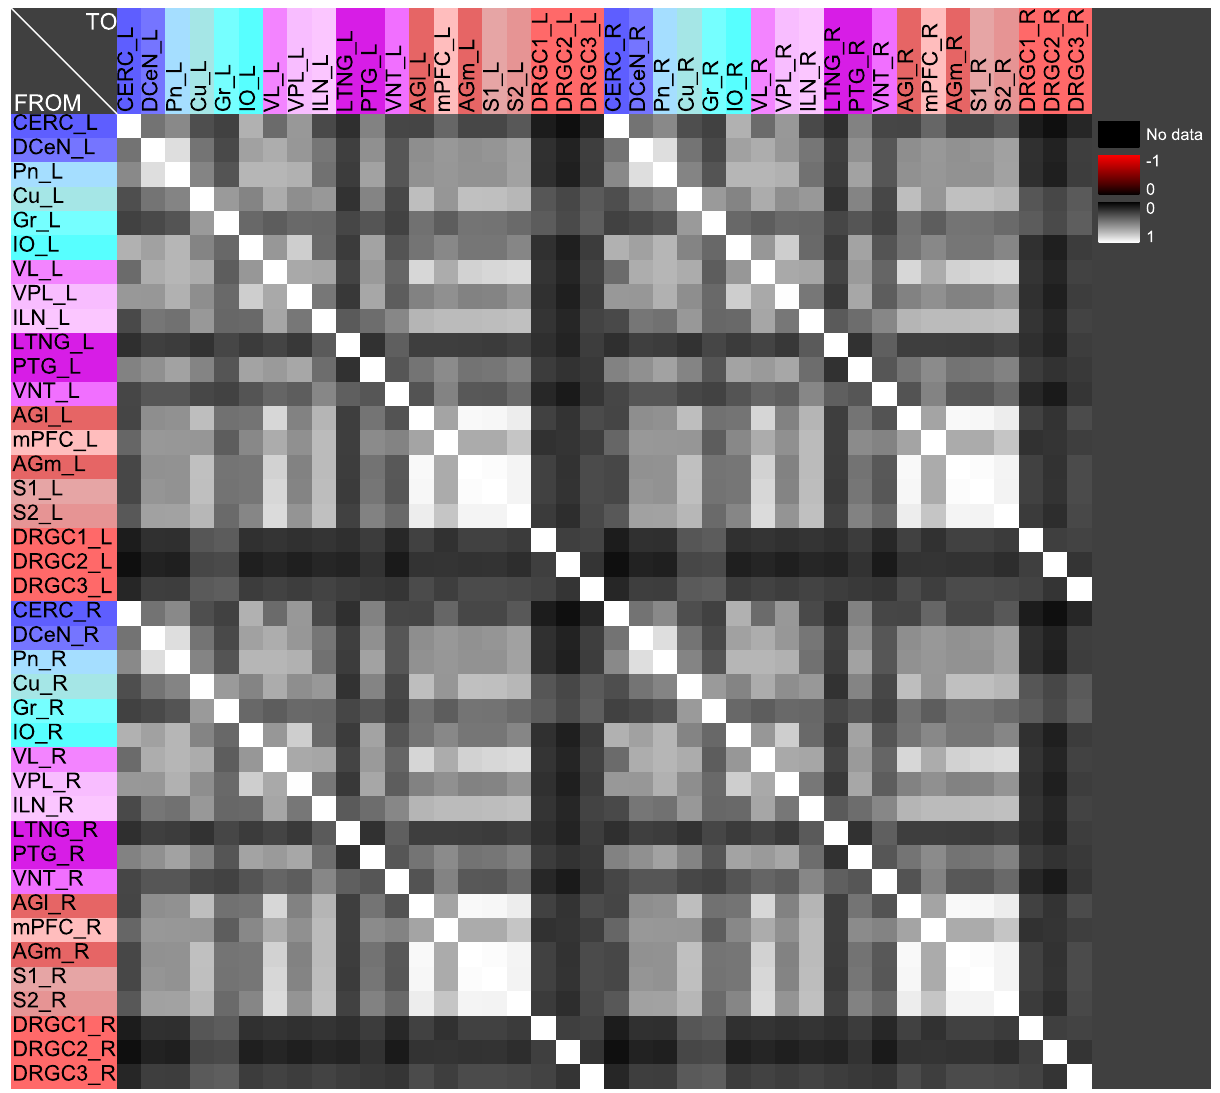
Fig 8. Average cross-correlation matrix of four parameters of the MM model. The average cross-correlation of the variation of four reaction parameters is shown. Large positive correlation values close to 1 indicate a strong similarity of concentrations of a pair of regions.